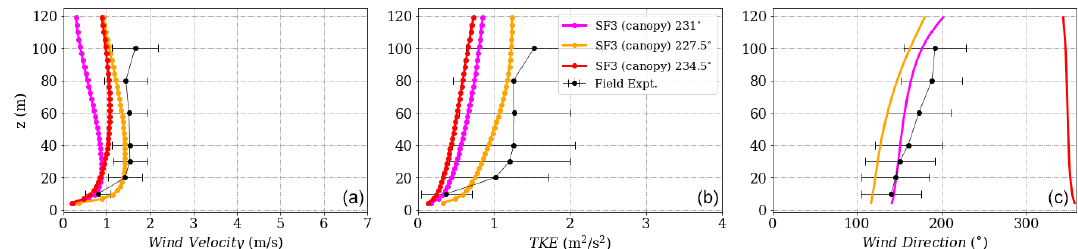
Figure D5. (a) Wind velocity magnitude, (b) wind direction and (c) turbulent kinetic energy at Tower 25 (tse09) for the SF3 (canopy) model.